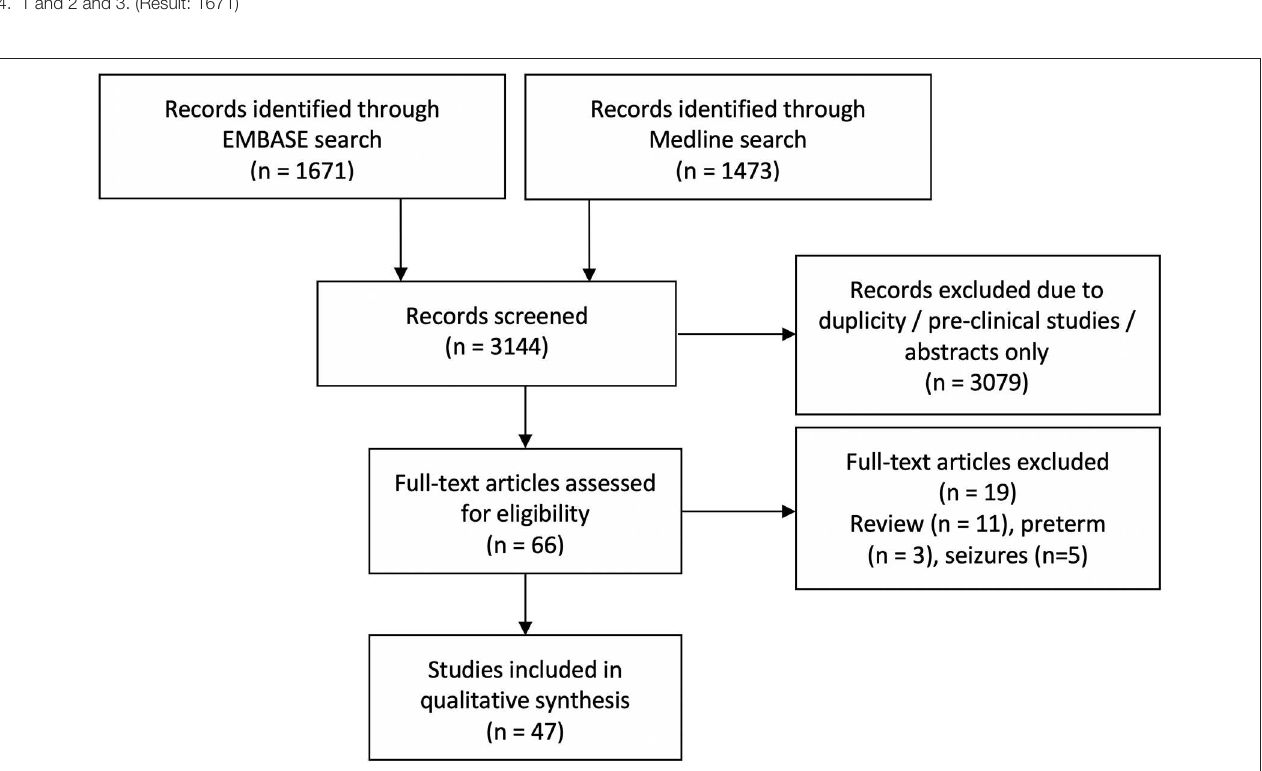
compare cerebral oxygenation between healthy controls and HIE infants